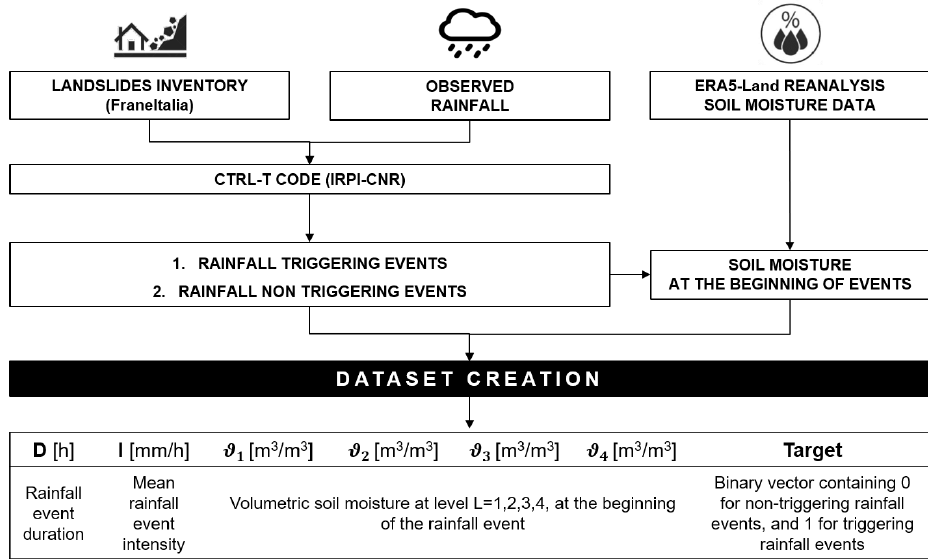
Figure 1. Schematization of the procedure followed for dataset construction.